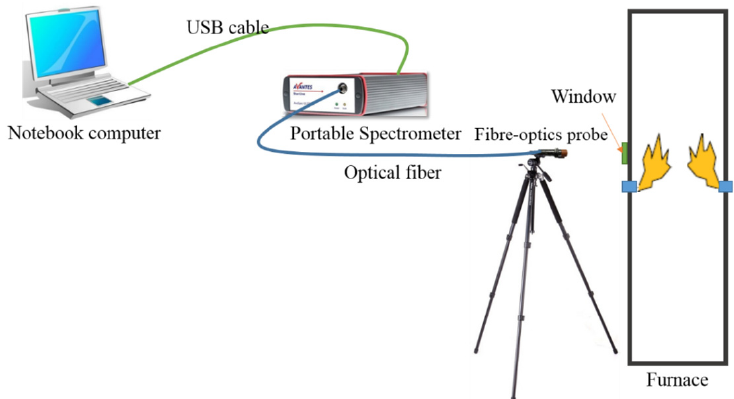
Figure 5. Schematic diagram of the spectrometer-based flame temperature measurement system. USB: universal serial bus.